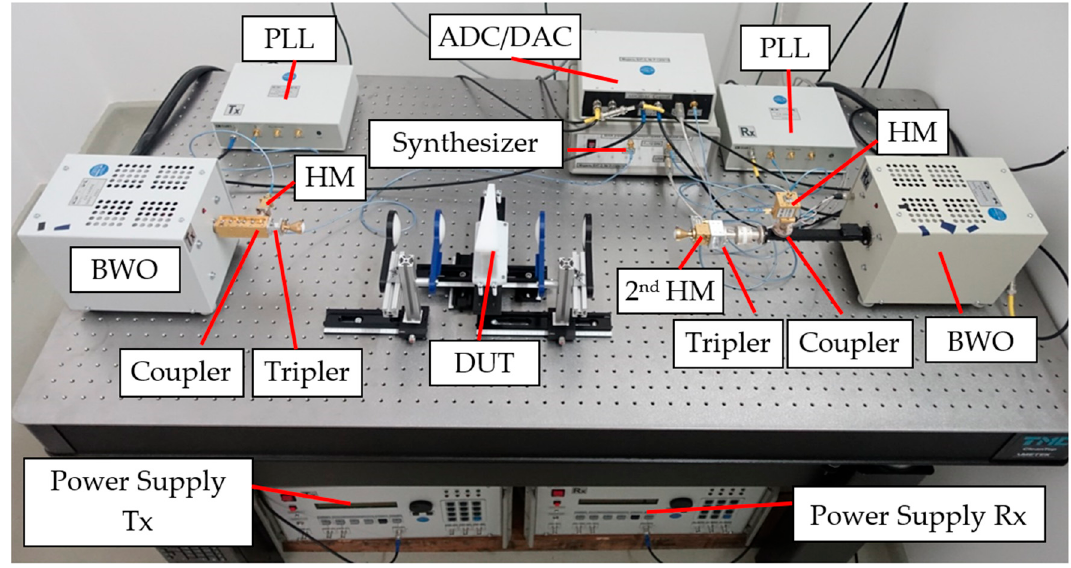
Figure 2. Photo of the THz spectrometer setup: PLL, phase locked loop; HM, harmonic mixer; Tx,